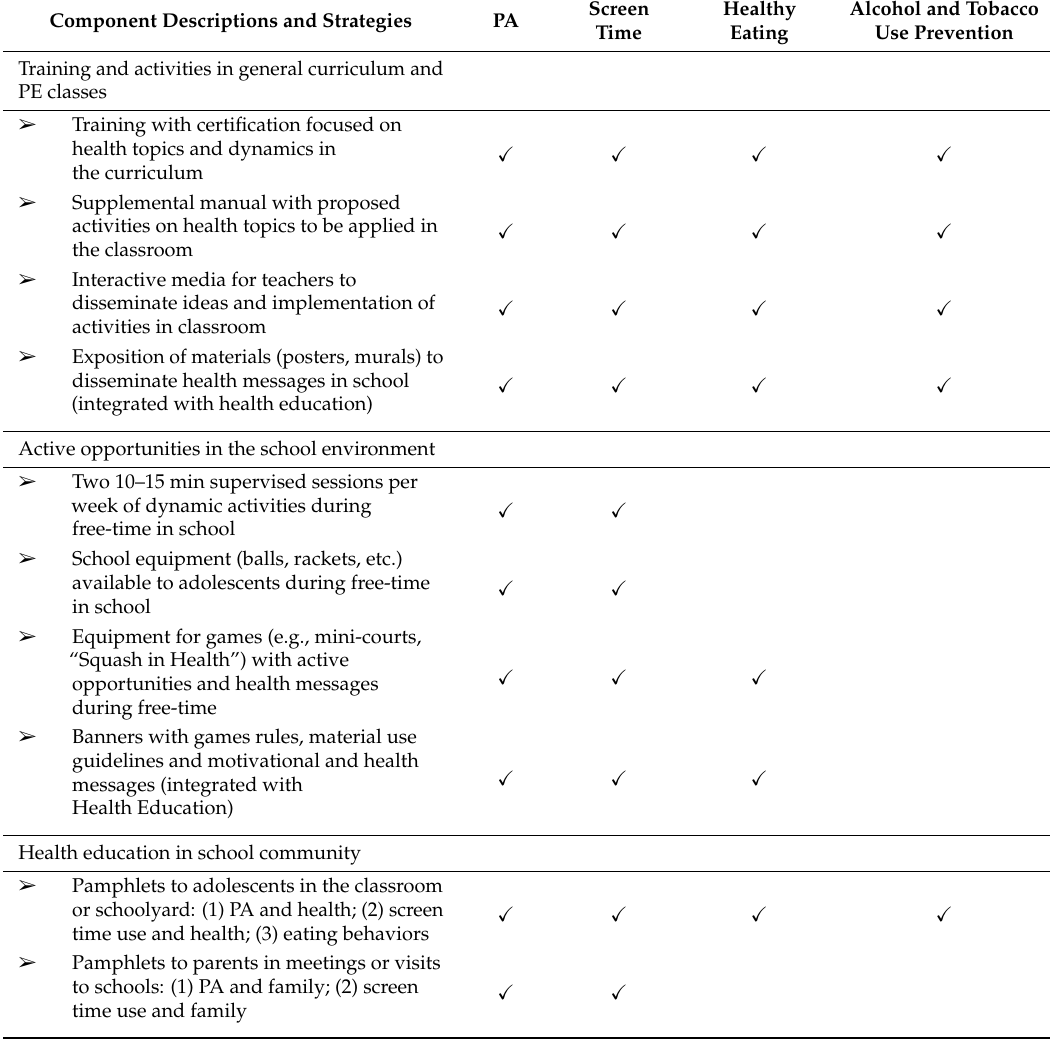
Table 1. Description of the Components and Lifestyle Factors Focused of the Fortaleça sua Sa ú de Program